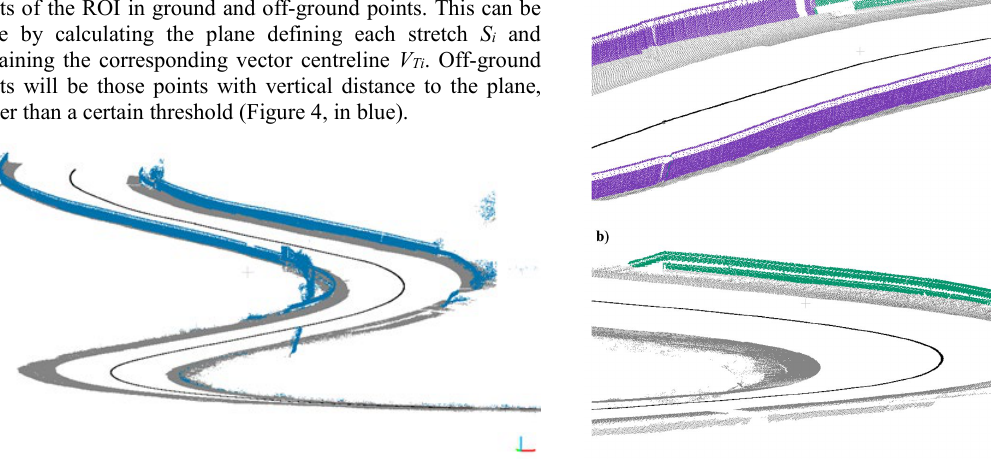
Figure 4. Ground points in grey, off-ground points in blue.